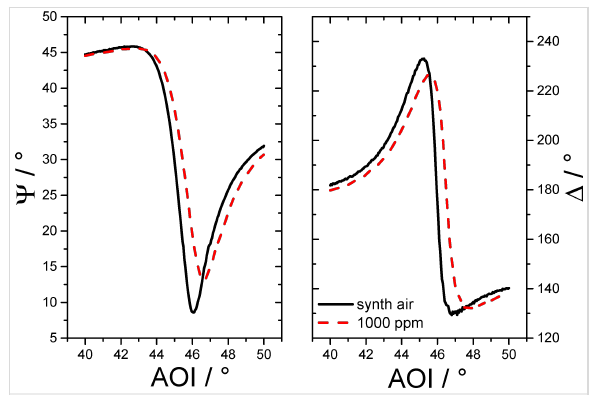
Figure 4: Changes in the Ψ and Δ angle spectrum due to changing gas atmosphere. Black / solid: synthetic air. Red/dashed 1000 ppm CO in synthetic air.